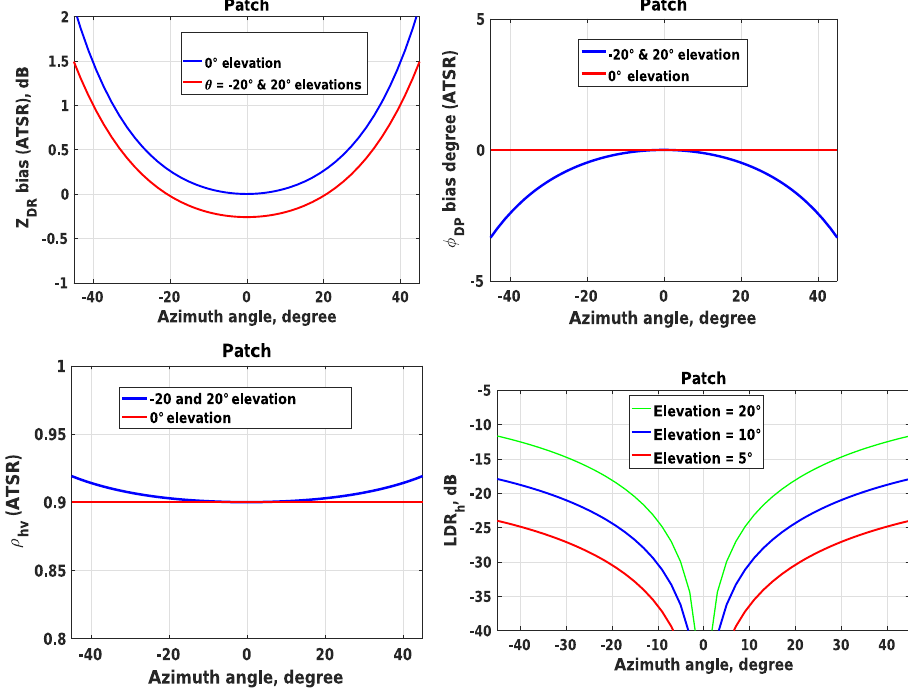
Figure 11. Biases in Z DR , (cid:56) DP , ρ HV , and LDR as a function azimuth and elevation scan angle of the radar beam.